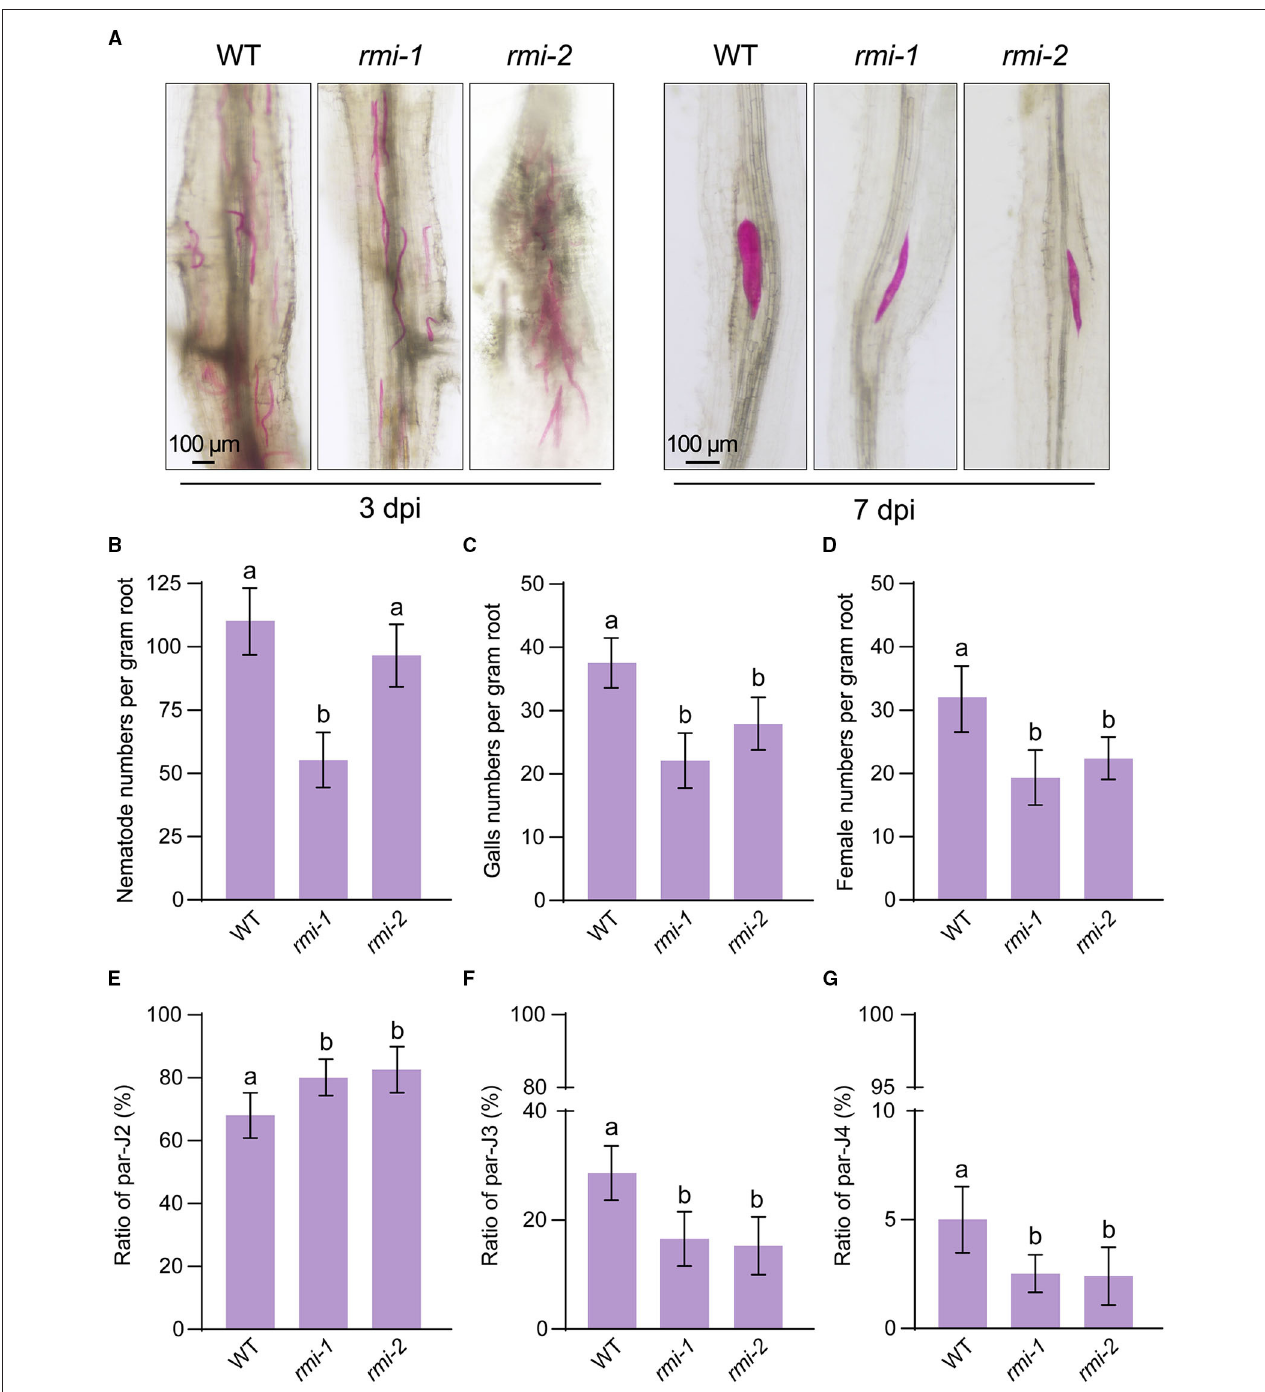
FIGURE 1 | Two soybean EMS mutants showed enhanced resistance to M. incognita . (A) Representative images of fuchsin-stained M. incognita parasites on wild-type and rmi1/2 soybean roots at 3 and 7 days postinfection (dpi). (B) M. incognita parasites numbers per gram of soybean roots at 3 dpi. (C, D) M. incognita gall ( C ) and female ( D ) numbers per gram of soybean roots at 30 dpi. (E–G) Statistical analysis of M. incognita parasites developmental stages consisting of par-J2 (E) / par-J3 (F) / par-J4 (G) nematodes to the total parasitic nematodes at 14 dpi. At least three biological replicates of (B–G) were performed, and the similar results were obtained. Data are presented as the mean ± S.D., n ≥ 10; one-way ANOVA (different letters represent p < 0.05).